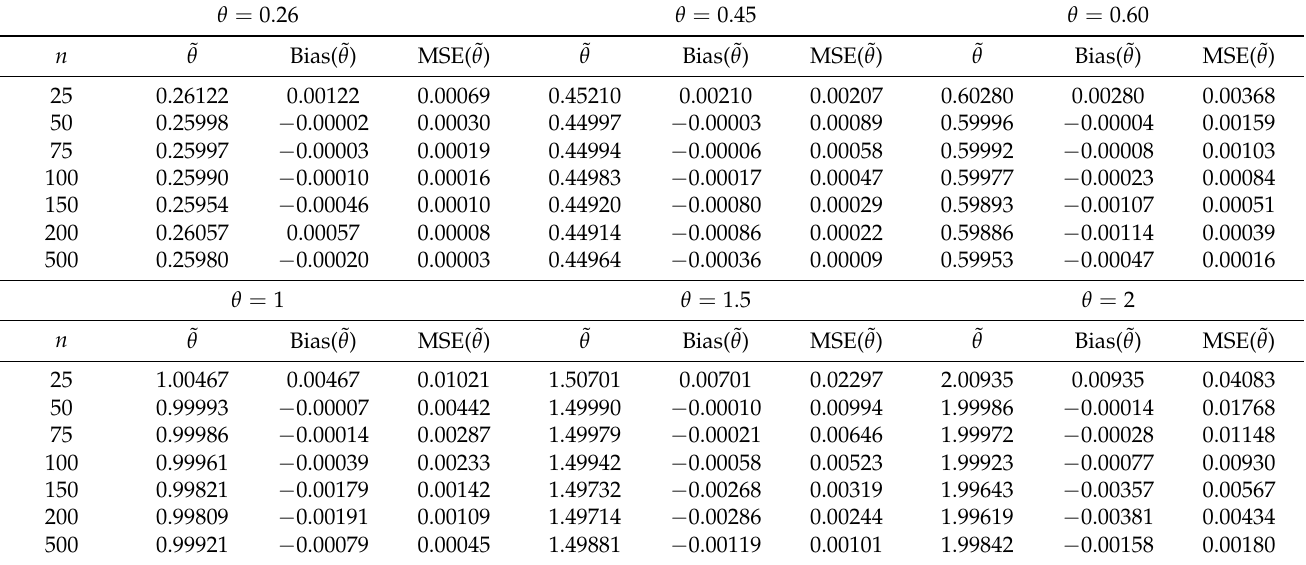
Table 2. Simulation results: LS estimates, bias, and MSE.